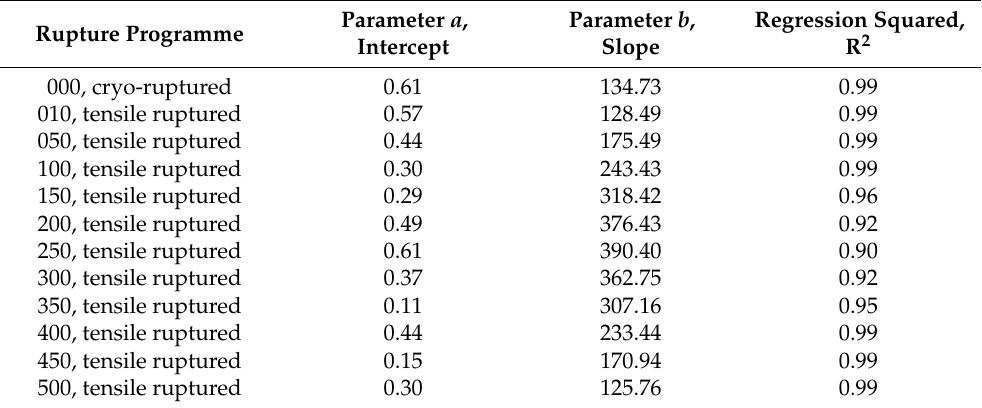
Table 5. Parameters from the fitting of straight line relating the concentration of the initial oil versus the concentration of the redistributed